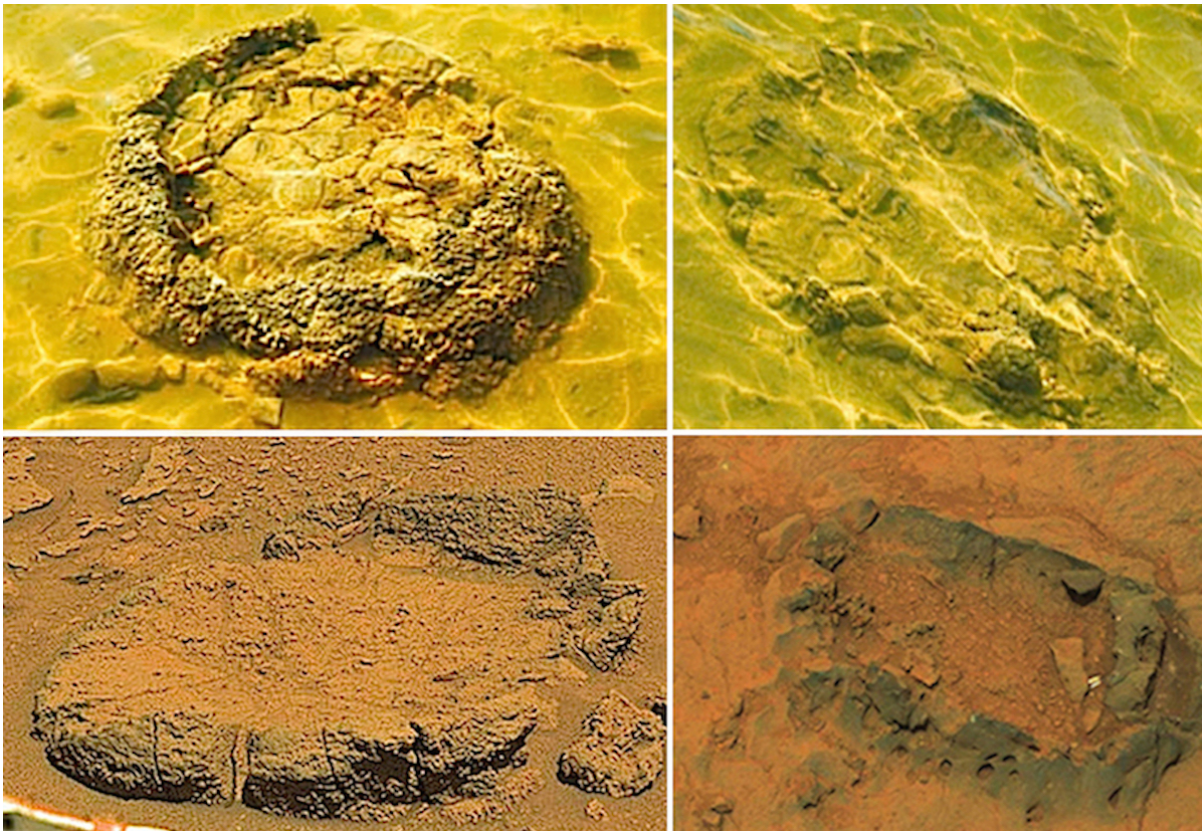
Figure 1. (Top row): Lake Thetis stromatolites with collapsed domed (Photo credit: Courtesy Government of Western Australia Department of Mines and Petroleum). (Bottom row) Left: Sol 529. Right: Sol 308. Photographed in Gale Crater: Martian specimens with evidence of concentric lamination and fossilized fenestrae. (From Joseph et al. 2020a, reproduced with